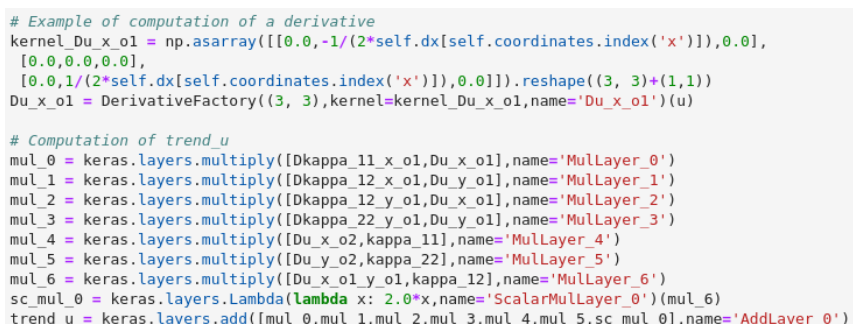
Figure 2. Part of the Python code of the NNDiffusion2DHeterogeneous class, which implements the diffusion equation (Eq. 4) as a neural network by using Keras (only one derivative is explicitly given for the sake of simplicity).